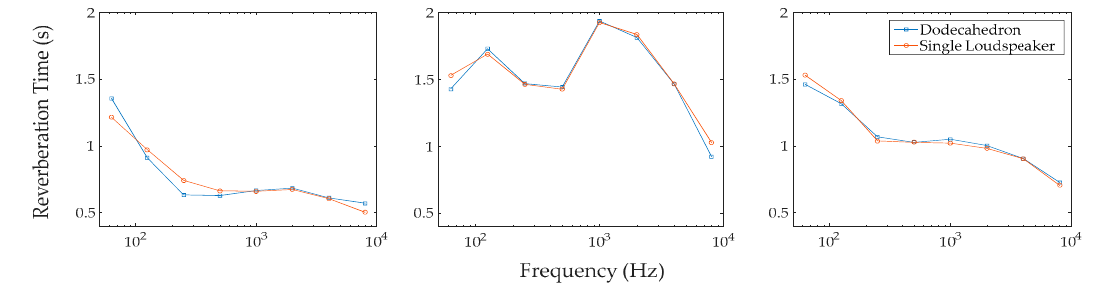
Figure 6. Reverberation Time (RT) for the small, midsized and large space (from left to right ).